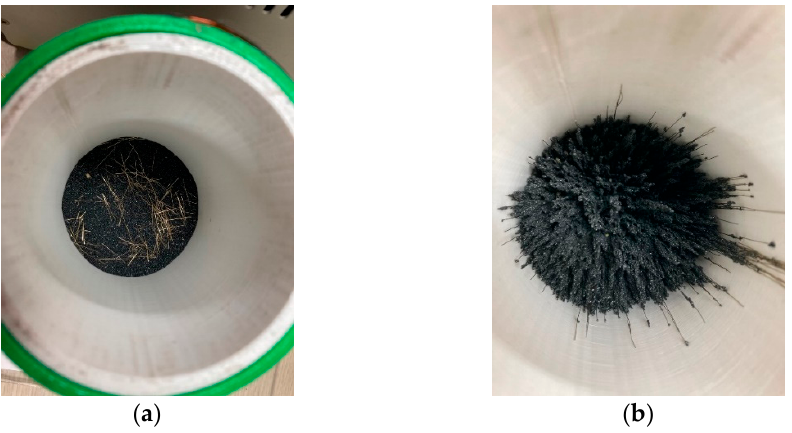
Figure 16. Steel slag and steel fibers under magnetic field: ( a ) before applying voltage, ( b ) after applying voltage .